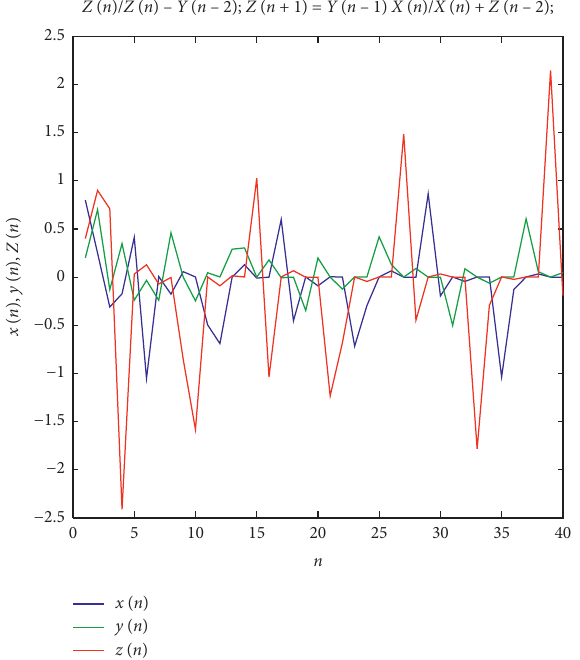
Figure 4: Difference system